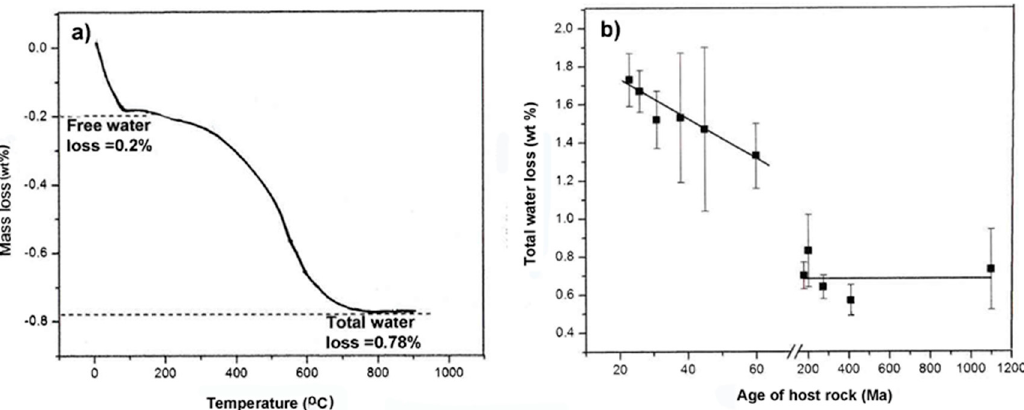
Figure 5. ( a ) A sketch plot of typical TGA (thermo gravimetric analysis) changes when powdered agate is heated to 1000 °C (after Yamagishi et al. [39]). ( b ) Total water loss from agate with respect to age of the host rock. Agate powders (<50 μ m) were heated at 1200 °C (after Moxon [40]).